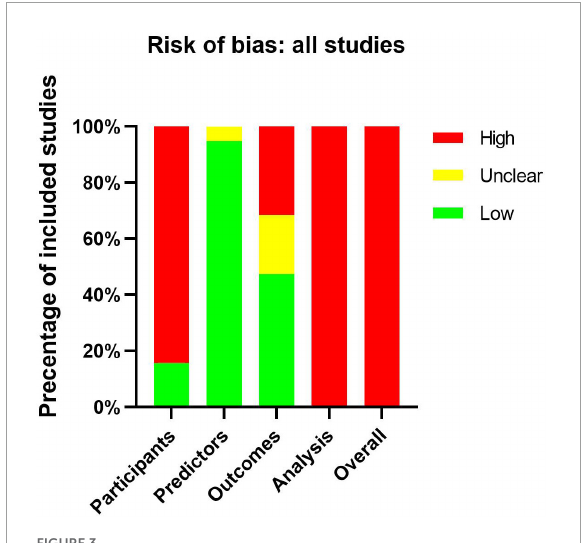
FIGURE3 Risk-of-bias assessment of the included studies by using the Prediction Model Risk of Bias Assessment Tool (PROBAST).